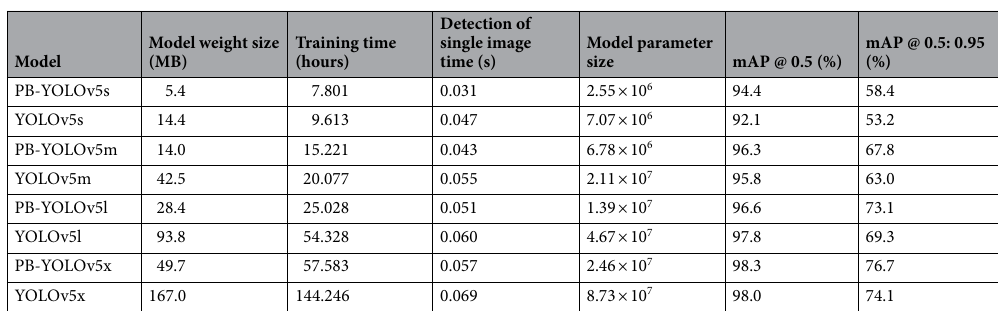
Table 5. Comparison table of model training weight and training